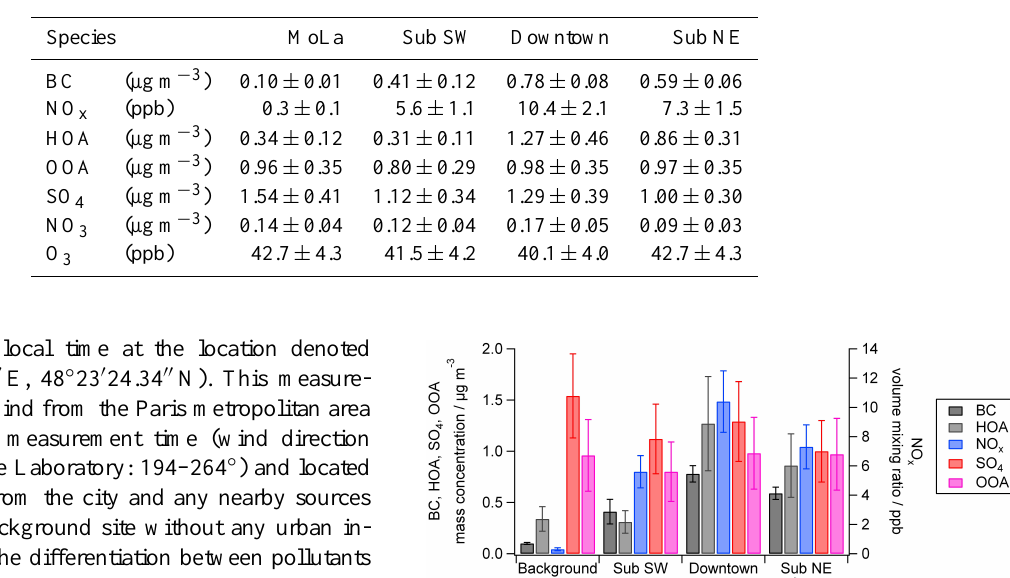
Table 4. Average mass concentrations and volume mixing ratios along with associated uncertainties for the time period of the Mobile Laboratory (MoLa) background measurement (15 July, 14:30 to 20:32).